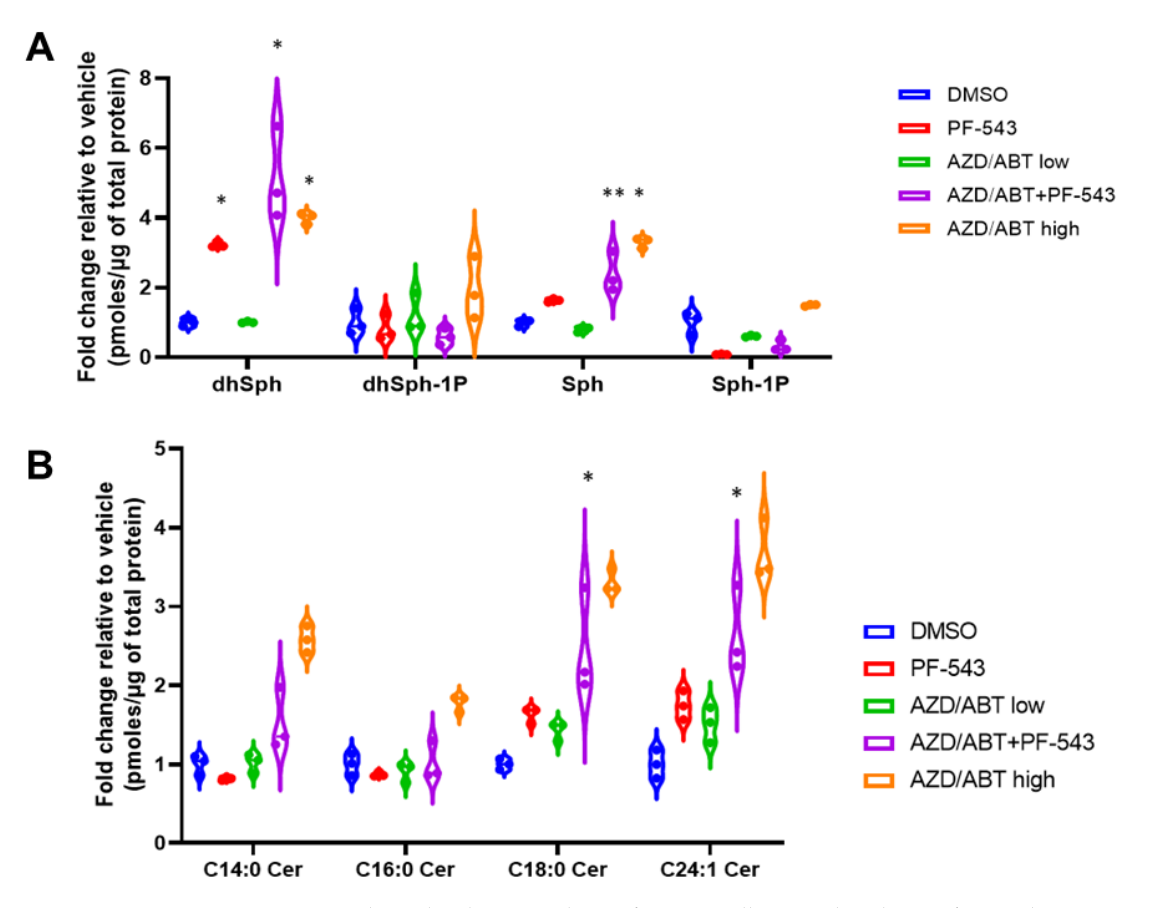
Figure 7. Sphingolipidomic analysis of DLD-1 cells treated with ABT/AZD alone or in combination with PF-543. Sphingolipidomic analysis was conducted on DLD-1 cell samples treated with ABT/AZD low (0.5 µM/0.25 µM) alone and in combination with PF-543 (5 µM) or ABT/AZD high (1.0 µM/0.5 µM) for 24 h, ( n = 3). Values are presented as pmoles of sphingolipid/µg of total cellular protein. ( A ). Sphingoid-bases and 1-phosphates. ( B ). Select ceramide species. ( * p ≤ 0.05, ** p ≤ 0.01 ) Asterisks indicate significant changes as reported in results section.